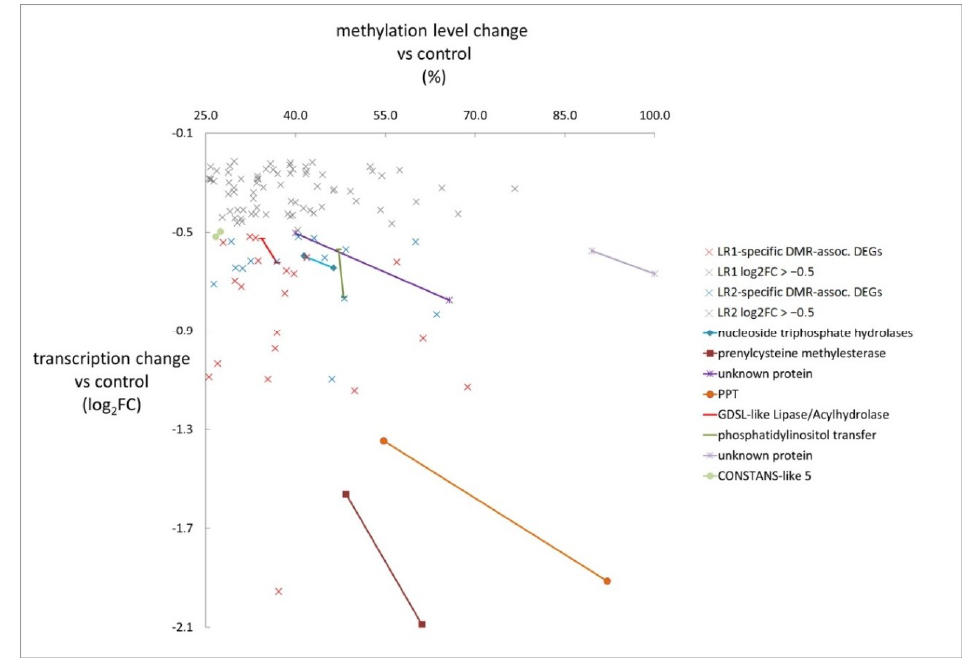
Figure 4. Expression and cytosine methylation changes of down-regulated DEGs associated with upstream hyper-methylated DMRs in epilines. Values for epiline LR1 and LR2 are indicated. Each DMR-associated DEG is shown with its transcription and methylation change, versus the control line. Epiline-specific DMR-associated DEGs are colored (red/blue crosses) when reaching the threshold of log 2 FC ≤ −0.5. Epiline-common DMR-associated DEGs are putative epialleles, and they are emphasized by connected data points and specific symbols as depicted in the legend. Table 4. Epiline LR1- and LR2-common DMR-associated DEGs showing gradual methylation changes and transcriptional changes (putative epialleles).